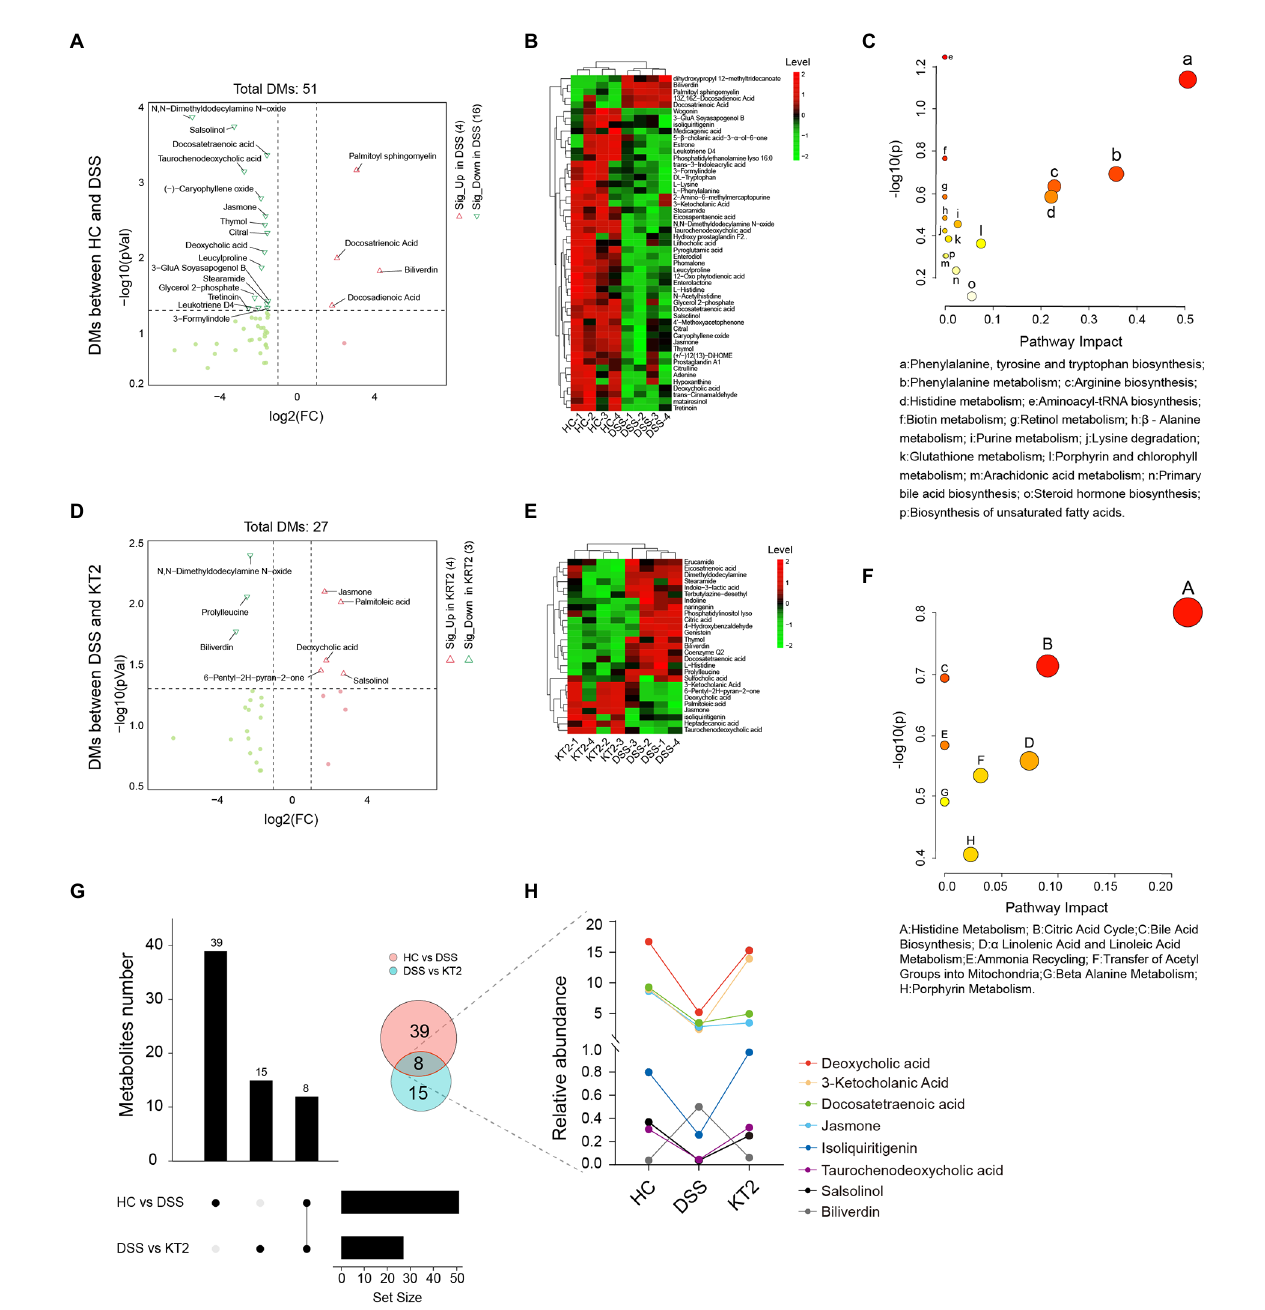
FIGURE 4 Fecal metabolomics for quantification of metabolites in both HC and DSS groups. (A) Volcano plot showing differentially accumulated [log 2 (FC) on X-axis] and significantly changed [ − log 10 ( p ) on Y-axis] metabolites in HC and DSS groups. (B) Hierarchical cluster analysis of metabolites in the HC and DSS groups based on z-normalized abundances. (C) Pathway enrichment and significance of DMs between HC and DSS groups. (D) Volcano plot showing differentially accumulated [log 2 (FC) on X-axis] and significantly changed [ − log 10 ( p ) on Y-axis] metabolites in DSS and KT2 groups. (E) Hierarchical cluster analysis of metabolites in DSS and KT2 groups based on z-normalized abundances. (F) Pathway enrichment and significance of DMs between DSS and KT2 groups. (G) Venn diagram of common DMs in HC and DSS groups, in the DSS and KT2 groups. (H) DM trends in different